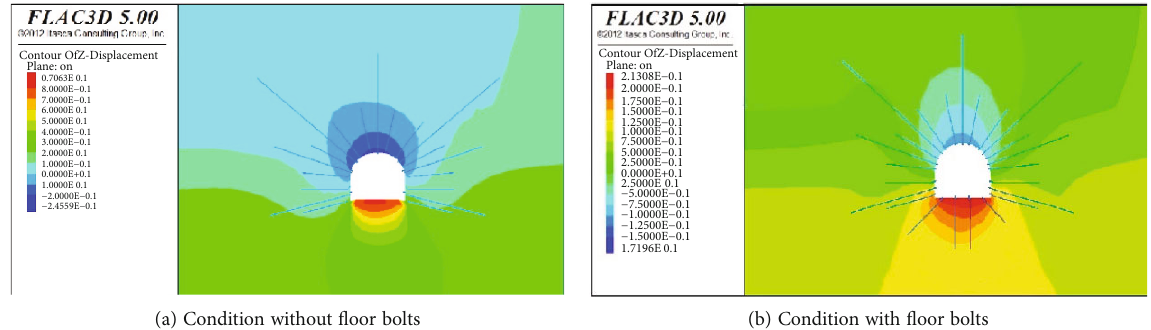
Figure 8: Numerical results of fl oor reinforcement.